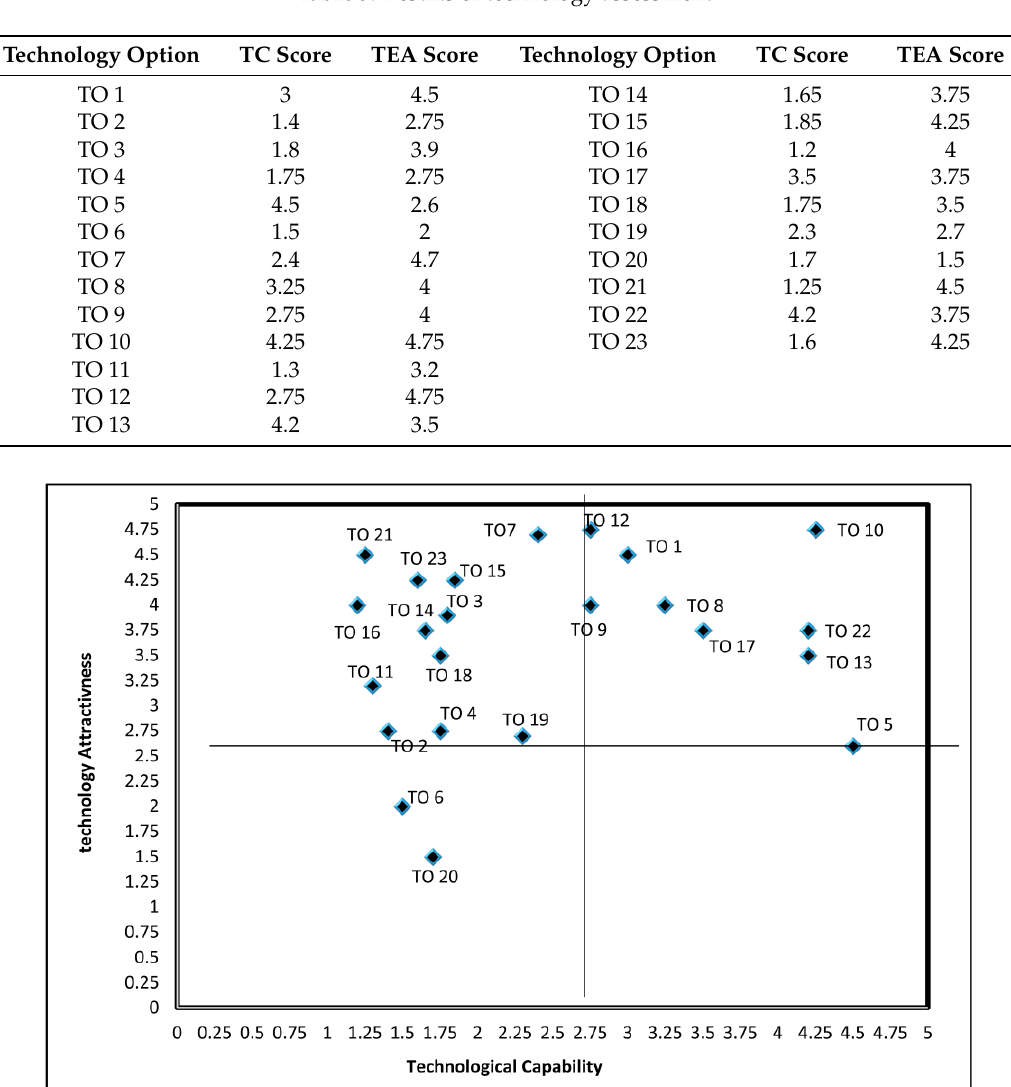
Figure 4. Capability – attractiveness portfolio of technology options (TOs).